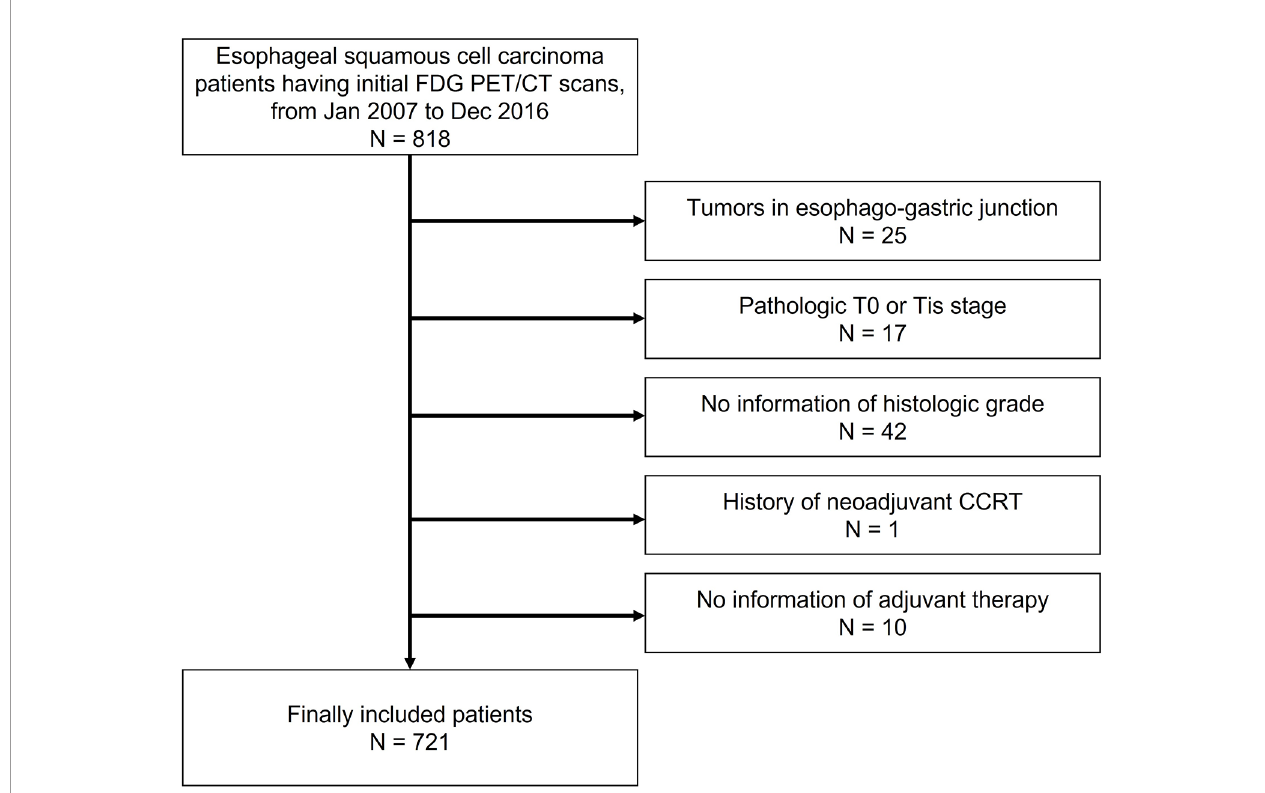
FIGURE 1 | Patient inclusion and exclusion criteria Eight hundred eighteen patients were retrospectively enrolled. Among them, patients with a primary tumor located in the esophago-gastric junction, with pathologic T0 or Tis, without pathologic information of histologic grade, with neo-adjuvant concurrent chemoradiotherapy, or without information of adjuvant therapy were subsequently excluded. Ultimately, 721 patients were